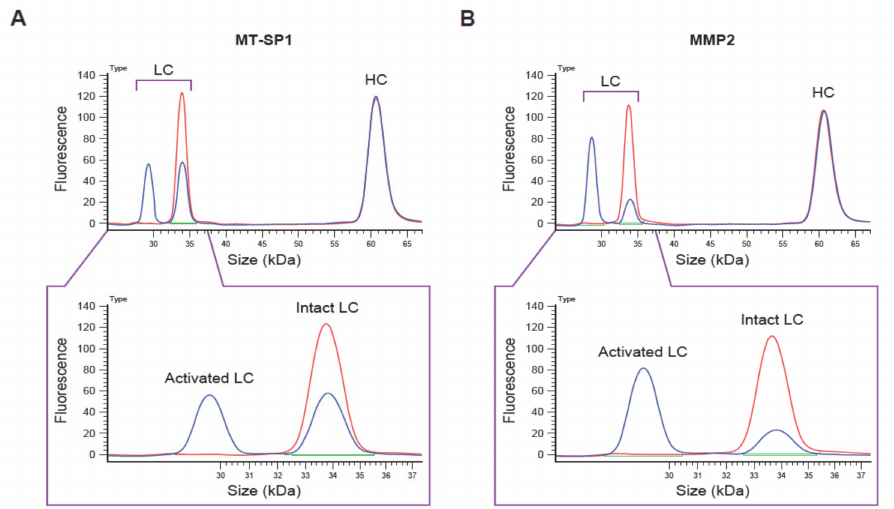
Figure 2. Example of capillary electrophoresis (CE)-based Pb-Tx cleavage assessment. Electrophero- grams of CE-based cleavage assessment of the C225-Sub1 Pb-Tx incubated with ( A ) recombinant human membrane-type serine protease 1 (MT-SP1) and ( B ) matrix metalloproteinase-2 (MMP-2) for 4 h. LC, light chain; HC, heavy chain; Pb-Tx, Probody